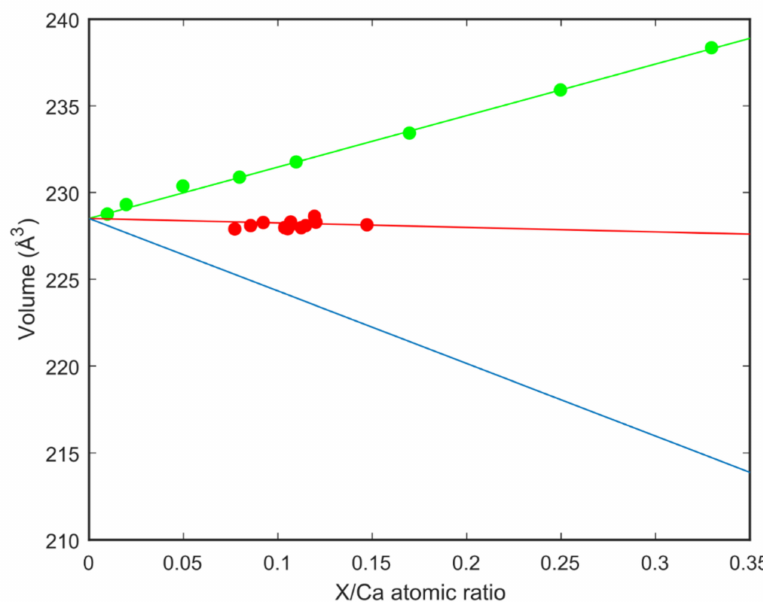
Figure 3. Data from this study compared to the unit cell volume change of the lattice estimated for substitution of Sr and Mg to Ca. X represents either Sr or Mg. Data from this study with the linear fit of the data points; Strontianite (SrCO3)-aragonite (CaCO3) solid solutions from [39] with the linear fit of the data points; Estimate for Mg substituting Ca in the